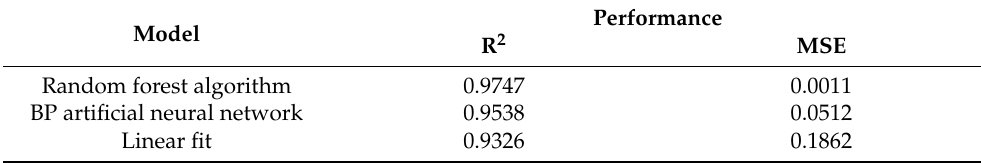
Table 4. Prediction model error comparison